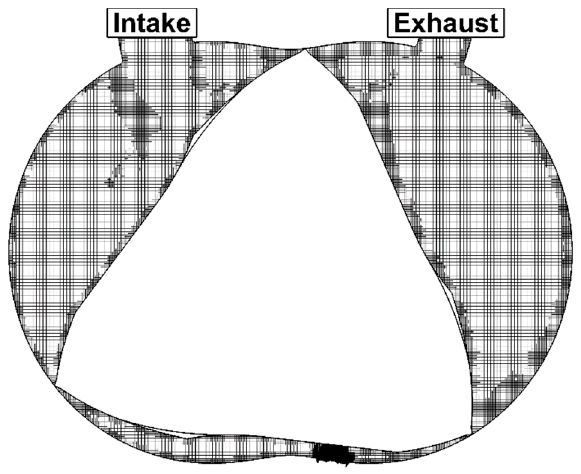
Figure 2. Two dimensional mesh arrangement in a slice taken through the center of the right spark plug at spark timing (ST).